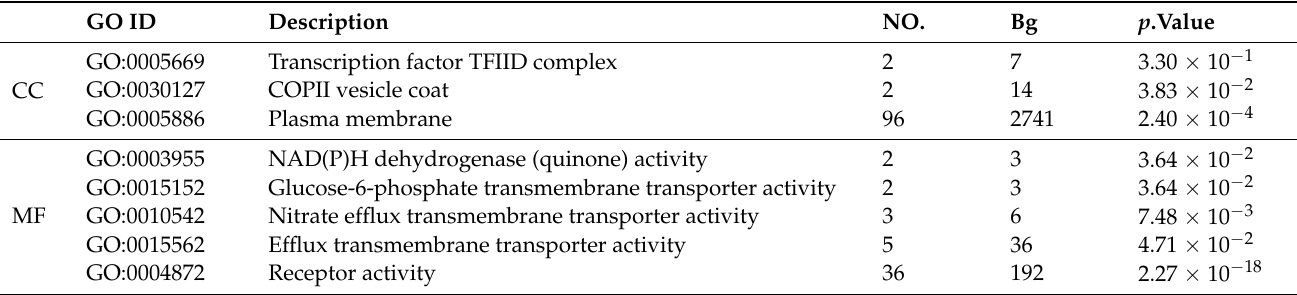
Table 2. GO analysis of predicted target genes of potato-derived